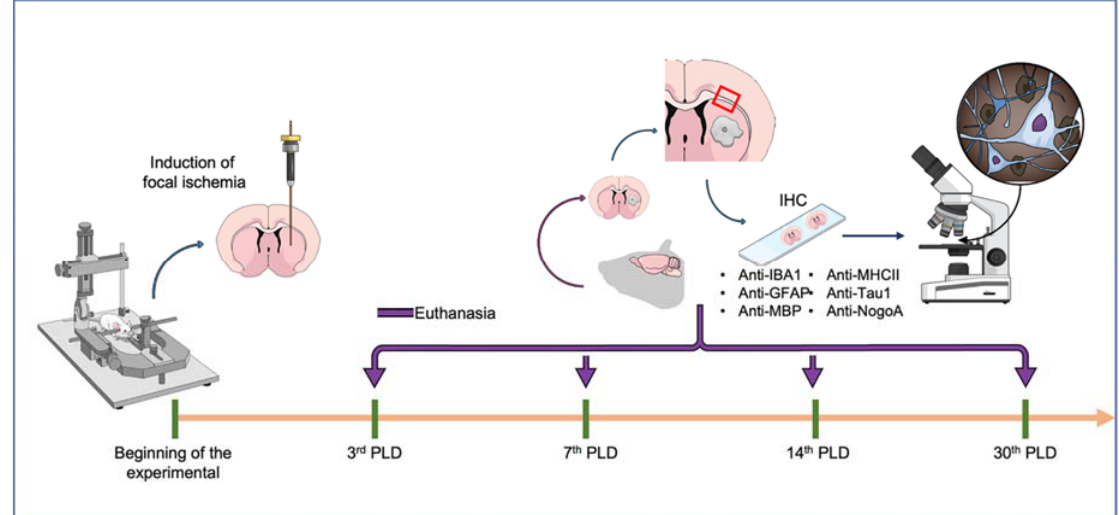
Figure 8. Schematic figure summarizing the experimental design. The focal ischemia was induced by endothelin-1 injection by a stereotaxic device with coordinated to striatum. Then, the animals were divided into four groups, considering different survival times after the ischemia (3, 7, 14, and 30 days), in which the brains were collected for immunohistochemistry analyses and further observations of the corpus callosum under bright-field microscopy.